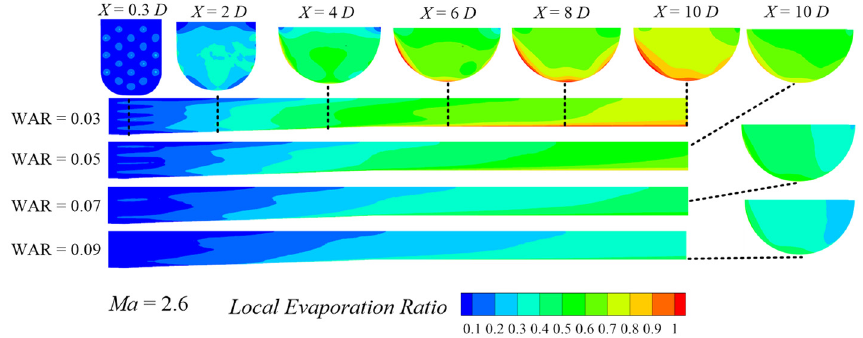
Figure 11. Local evaporation ratio at different sections.